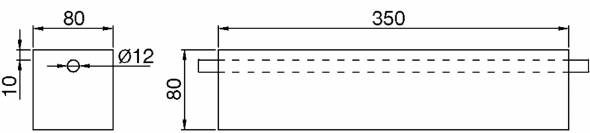
Figure 2. Scheme of the reinforced cement mortar specimens. All dimensions in